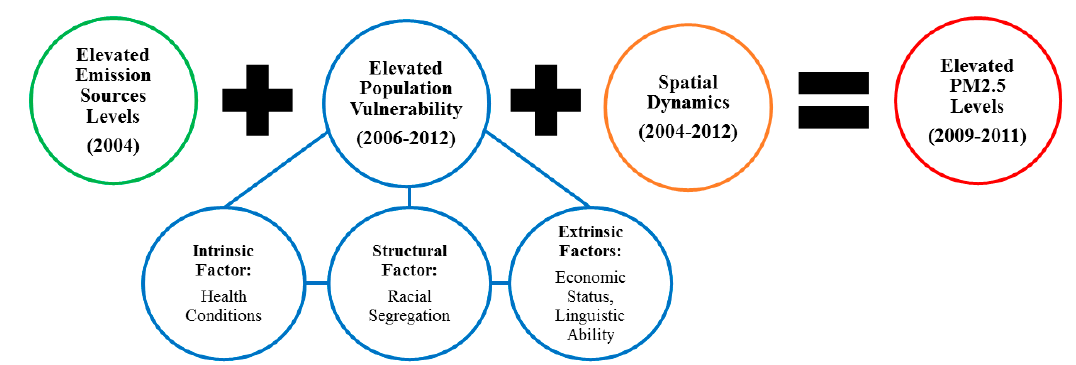
Figure 1. Racialized structural vulnerability framework for modeling population vulnerability and the multivariable correlates of PM 2.5 levels in California.